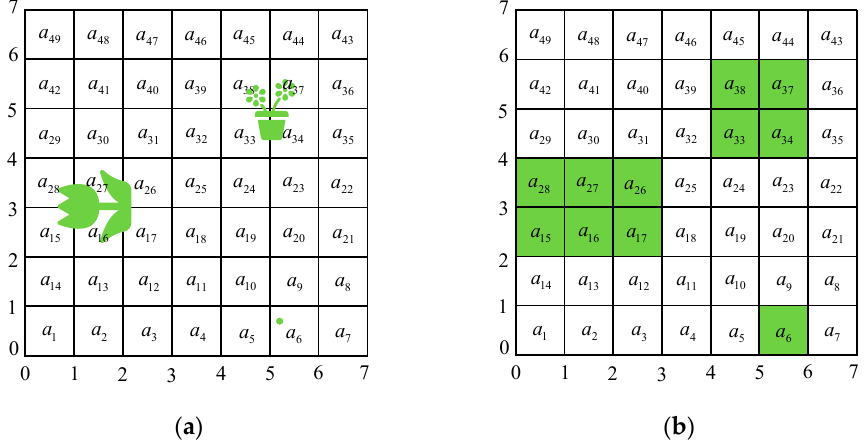
Figure 5. Puffed grid map: ( a ) irregular obstacles; ( b ) swelling of obstacles.